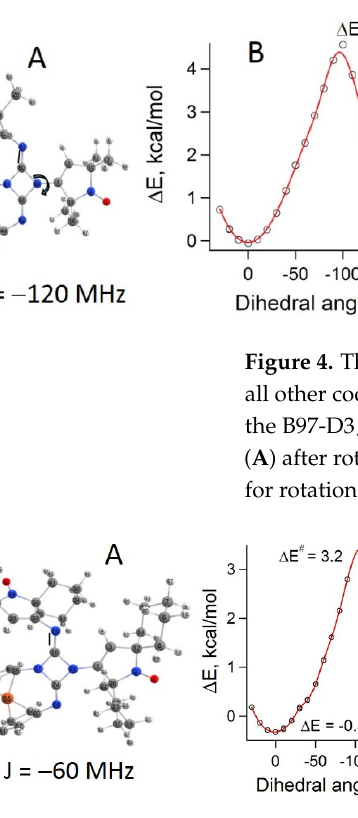
Figure 5. Energy scans ( B , D ) performed by variation of the dihedral angle with optimization of all other coordinates for rotation around either the N3–C ( B ) or N5–C ( D ) bond for biradical 4 at the B97-D3/def2-TZVP level of theory. Δ E # stands for rotation barriers in kcal/mol, Δ E stands for energy differences between minima in kcal/mol. Geometries of conformers of 4 are also depicted: ( C ) after optimization of XRD structure, ( A ) after rotation around the N3–C bond, and ( E ) after rotation around the N5–C2 bond.